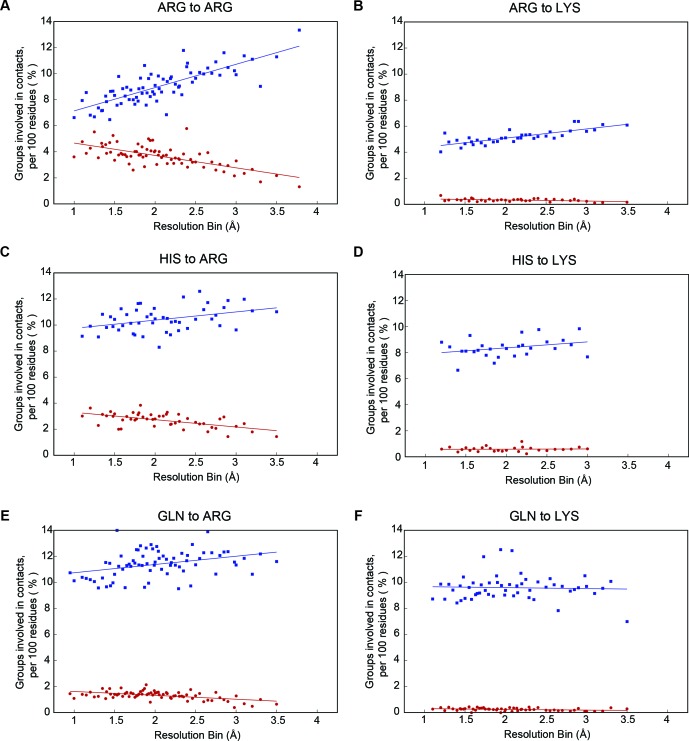
Selected sidechain-to-sidechain contact frequencies by resolution.Percentage of residues involved in planar contacts are shown in red, and percentage in any other non-planar VDW contact are shown in blue, with panels showing contacts by sidechain group (for panels A-F: R to R, R to K, H to R, H to K, Q to R, and Q to K). We observe that the increase in planar pi-pi contacts to arginine at higher resolution comes at the expense of non-planar VDW contacts (panels A, (C and E). In contrast, contacts made to an arbitrary surface plane at the end of lysine sidechains do not show this increase in planar orientation with resolution (panels B, D and F).